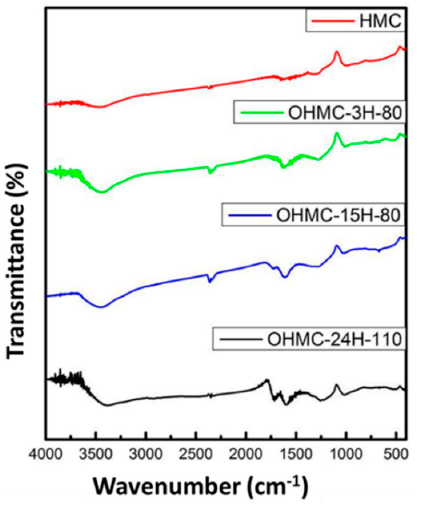
Figure 3. Infrared (IR) spectra of HMC and O-HMC with modified parameters.